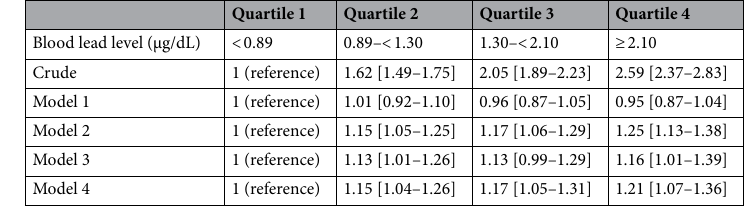
Table 4. Association between quartiles of blood lead level and hypertension. Figures are expressed as odds ratio [95% confidence interval]. Model 1: adjusted for age, gender and ethnicity. Model 2: adjusted for age, gender, ethnicity and waist circumference. Model 3: adjusted for age, gender, ethnicity, waist circumference, poverty to income ratio, education and ever cigarette smoking. Model 4: adjusted for age, gender, ethnicity, waist circumference, poverty to income ratio, education, ever cigarette smoking, diabetes and stage 3–5 chronic kidney